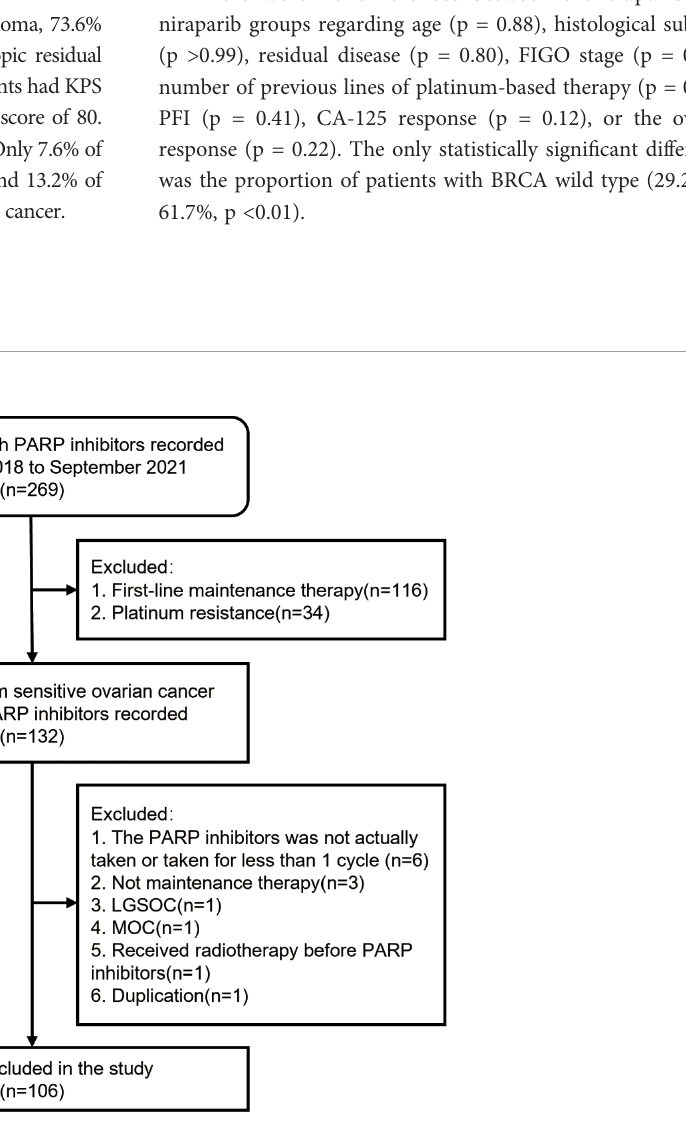
FIGURE 1 Enrollment fl ow diagram. Abbreviations: PARP, Poly ADP-ribose Polymerase; LGSOC, low-grade serous ovarian cancer; MOC, mucinous ovarian